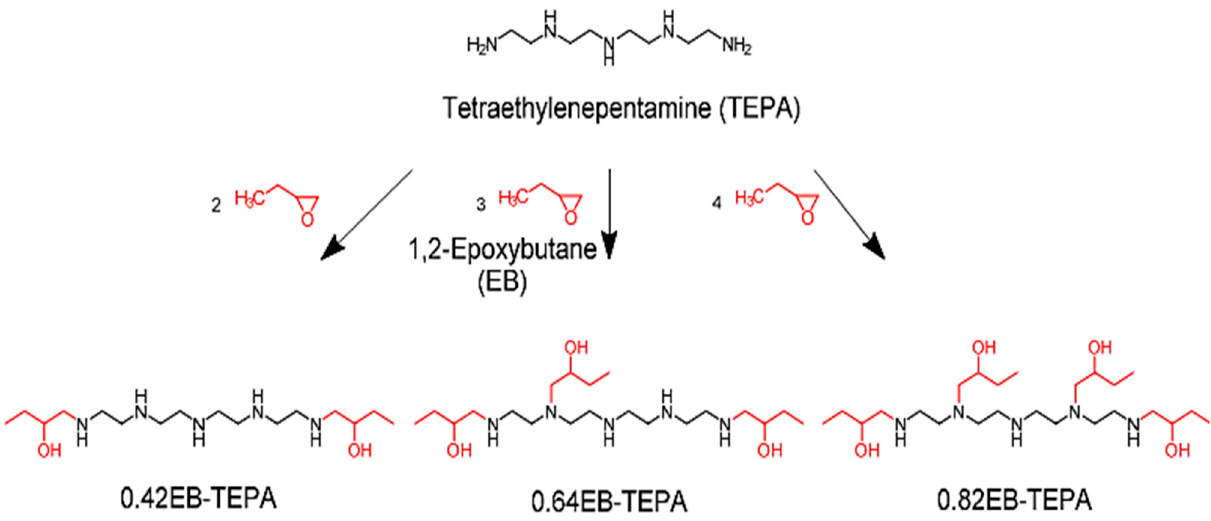
Figure 1. Functionalization of TEPA using different amounts of EB. Reprinted from [84] with permission from the American Chemical Society.